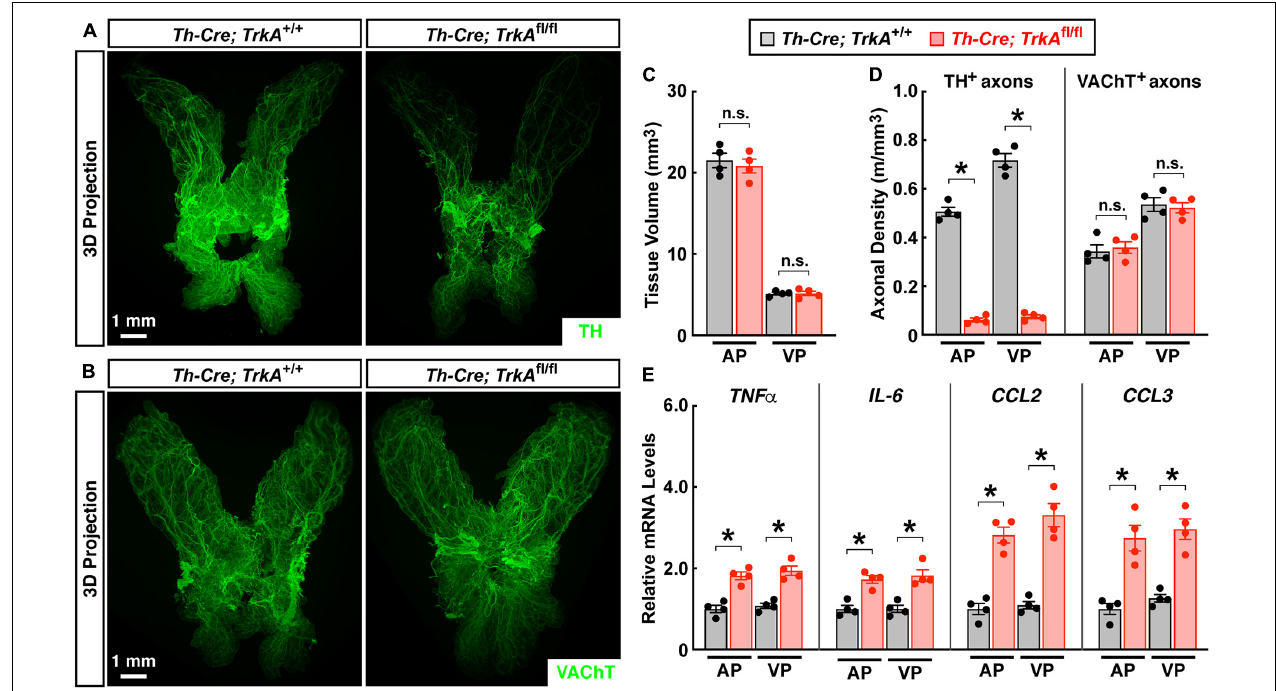
FIGURE 5 | Genetic ablation of sympathetic innervations produced sterile inflammation in the prostate. The prostates of Th-Cre; TrkA fl / fl and control Th-Cre; TrkA + / + mice of 8 weeks old were harvested. (A,B) The intact prostates were subjected to the whole-tissue immunolabeling of TH (A) or VAChT (B) . Representative 3D projections of the lightsheet imaging are shown. (C) Tissue volumes of the anterior (AP) and ventral prostate (VP) of Th-Cre; TrkA fl / fl and control Th-Cre; TrkA + / + mice were quantified. n = 4, mean ± SEM, n.s., not significant (two-way ANOVA test). (D) TH-positive sympathetic axons or VAChT-positive parasympathetic axons in the anterior (AP) and ventral prostate (VP) were quantified. n = 4, mean ± SEM, * p < 0.05, n.s., not significant (two-way ANOVA test). (E) mRNA levels of pro-inflammatory cytokines and chemokines in the anterior (AP) and ventral prostate (VP) of Th-Cre; TrkA fl / fl and control Th-Cre; TrkA + / + mice were analyzed by the qPCR analysis. n = 4, mean ± SEM, * p < 0.05 (two-way ANOVA test).